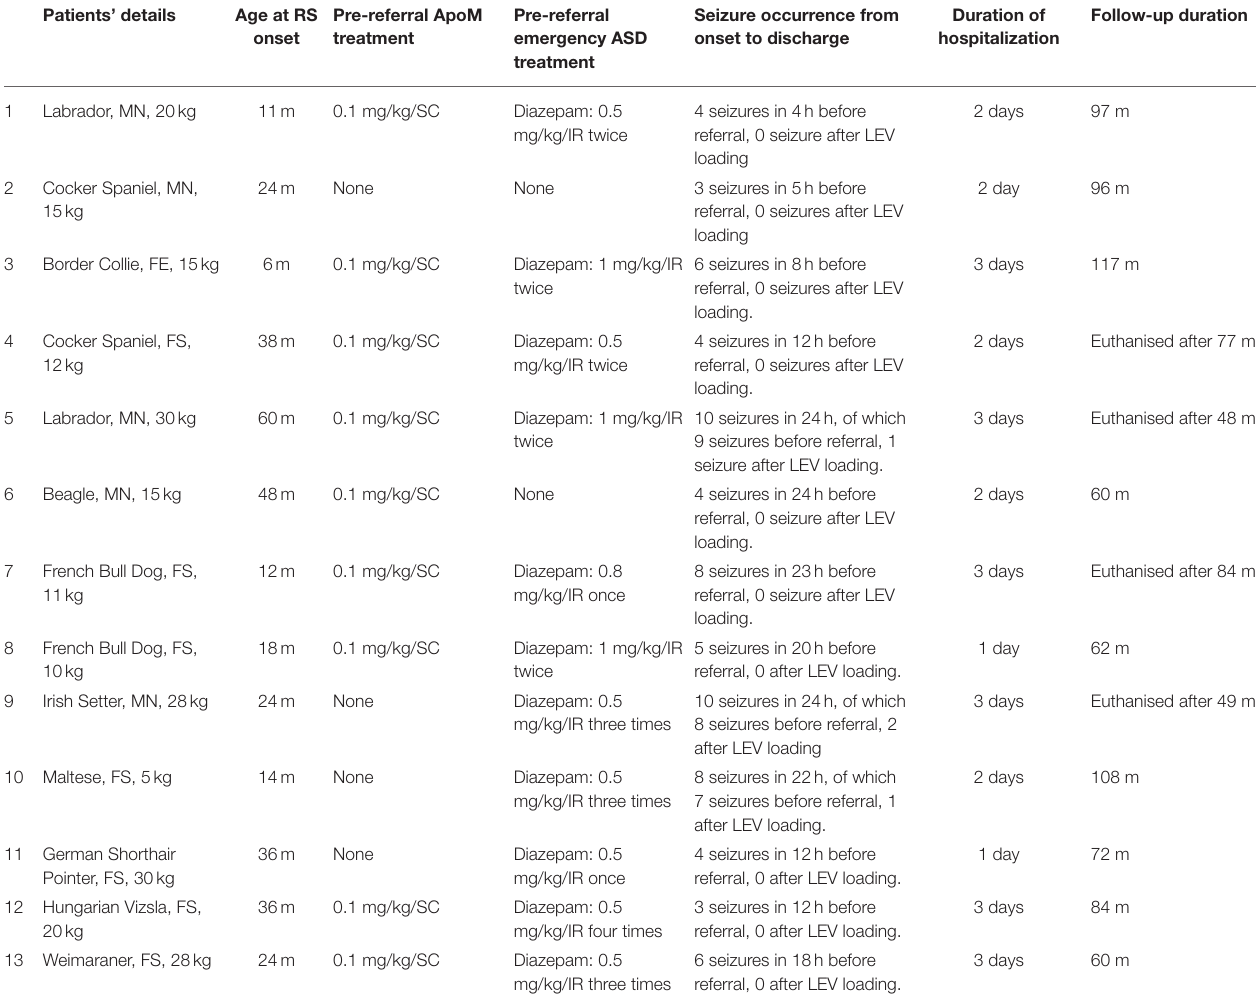
TABLE 1 | Signalment, body weight, treatment, and follow-up details of the 13 dogs with highly suspected exogenous toxicity. Patients’